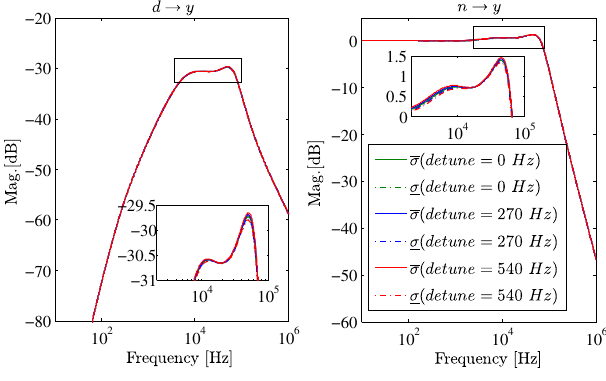
FIG. 10. The singular value of the closed-loop transfer function matrix from d and n to y in terms of different cavity detuning δω . The ¯ σ in each transfer function indicates their H ∞